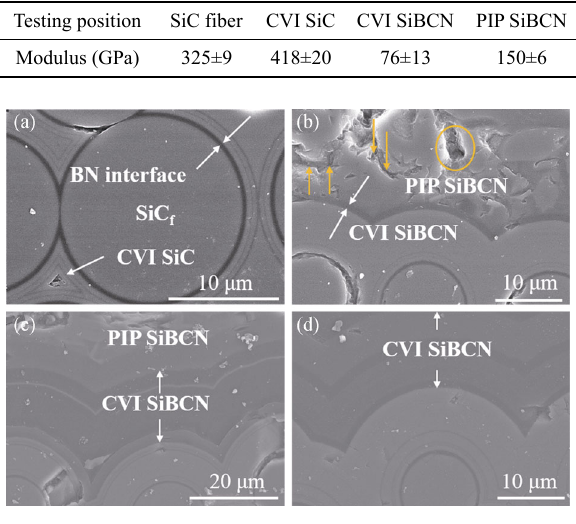
Fig. 1 Cross-section morphologies of SiC f /SiC–SiBCN composites: (a) SiC f /SiC, (b) 1#, (c) 2#, and (d)